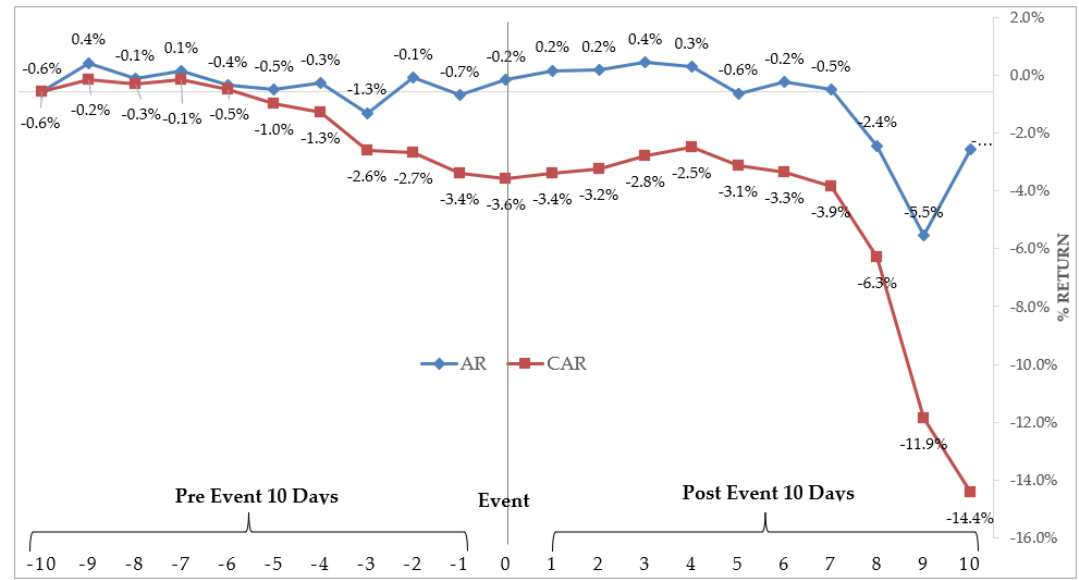
Figure 6. Abnormal returns and cumulative abnormal returns (MRMA method). In Figure 7, the abnormal returns are negative on day − 10, positive between days − 9 and − 7 (similar to the obtained cumulative abnormal returns), and then remain negative until the day of the event. However, the abnormal returns from day 1 to day 4 are positive and then become negative from days 5 to 10, whereas the cumulative abnormal returns from day 4 remain negative.